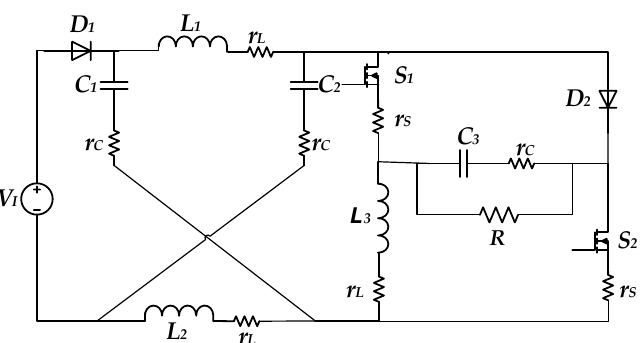
Figure 6. The circuit diagram of the proposed converter with non-ideal elements.